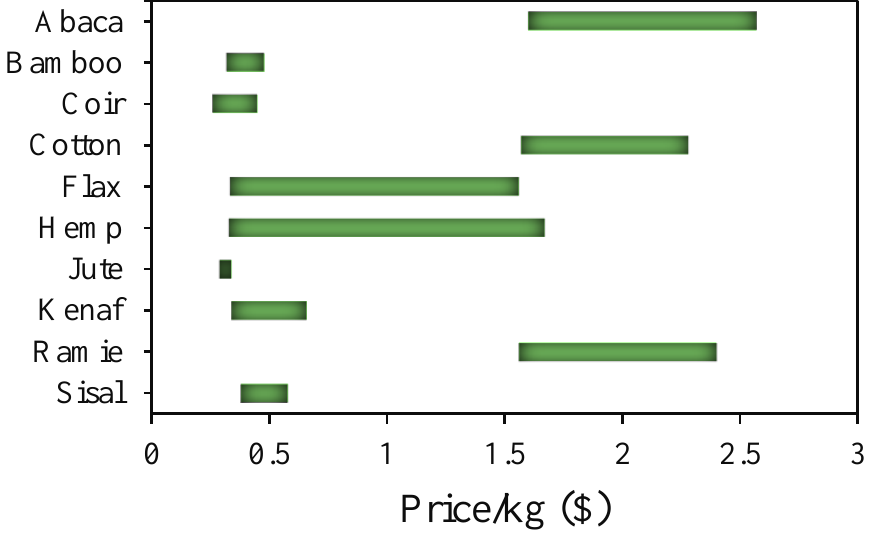
Figure 2. Comparison of cost/weight of different fibers.